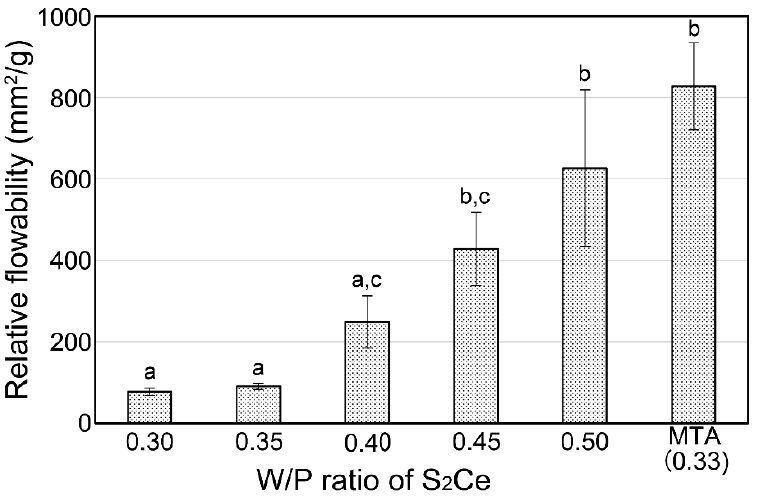
Figure 4. Relative flowability of the S 2 Ce cement paste mixed with various W/P ratios. Result of MTA was derived from a previous report [14]. Columns with different letter(s) (a – c) are statistically different ( p < 0.05).